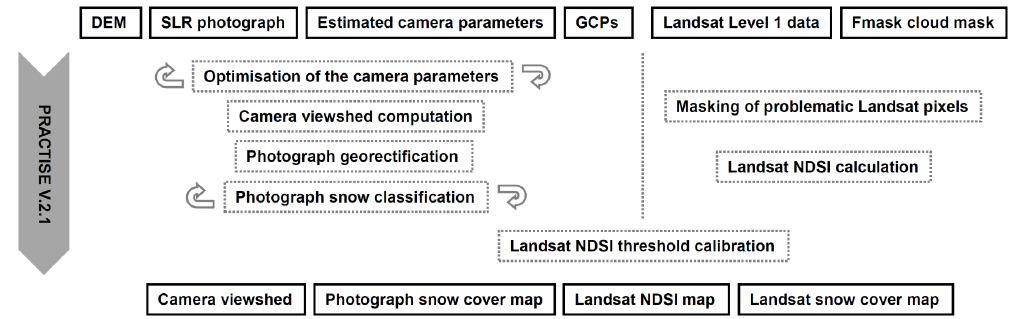
Figure 8. General flow chart of PRACTISE V.2.1 for the SLR photograph and Landsat 7 ETM + image on 17 November 2011: inputs needed and output data generated in the PRACTISE run are depicted in solid black boxes at the top, respectively, at the bottom. All modules (dashed boxes) are active in the program evaluation and are executed downwards. Arrows illustrate activated interactive modes in the modules as the user can restart and adapt these routines during the program